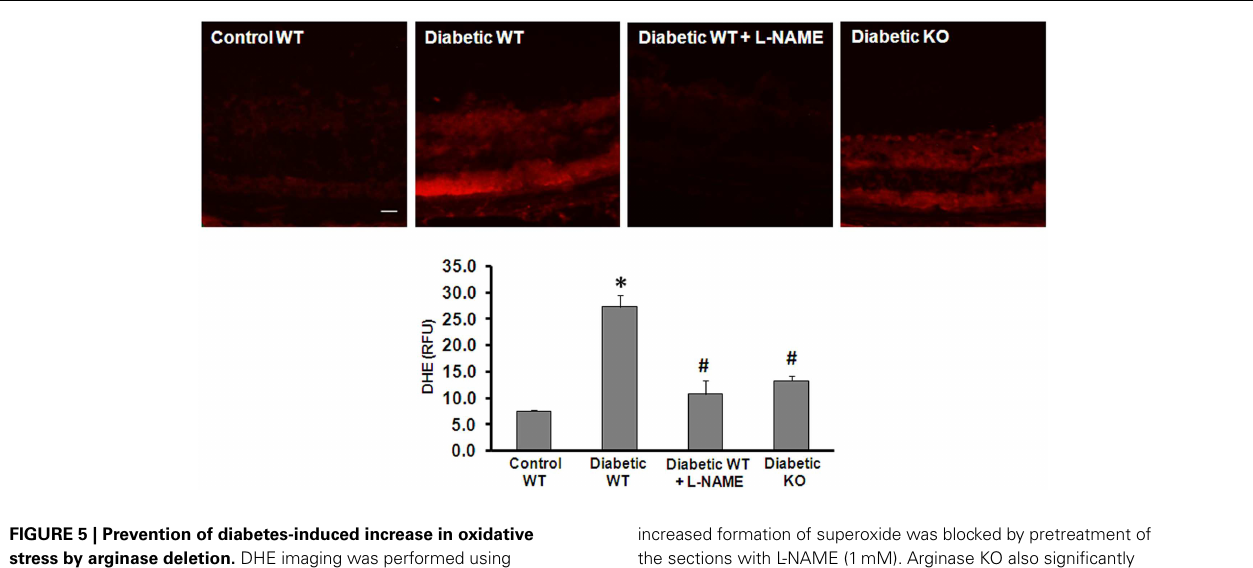
FIGURE 5 | Prevention of diabetes-induced increase in oxidative stress by arginase deletion. DHE imaging was performed using flash frozen retinal sections from wild type control, wild type diabetic, and diabetic AI + / − AII − / − mice (KO). Diabetic retinas display increased production of ROS as compared with the controls.The